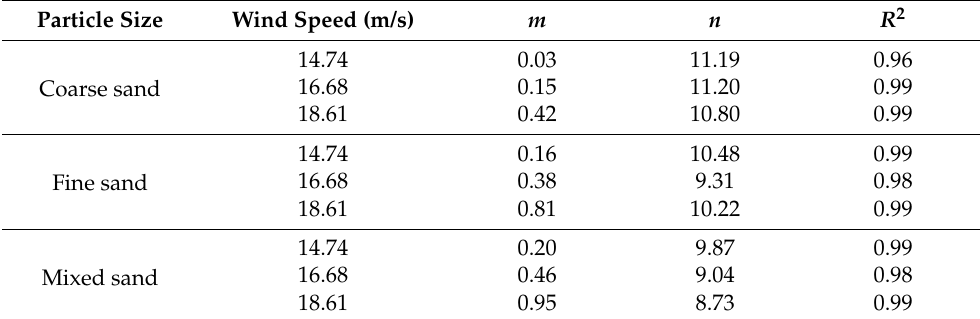
14.74 Mixed sand Fitted function: E k = m exp ( − nz ) ; R 2 is the correlation coefficient at 0.05 significance